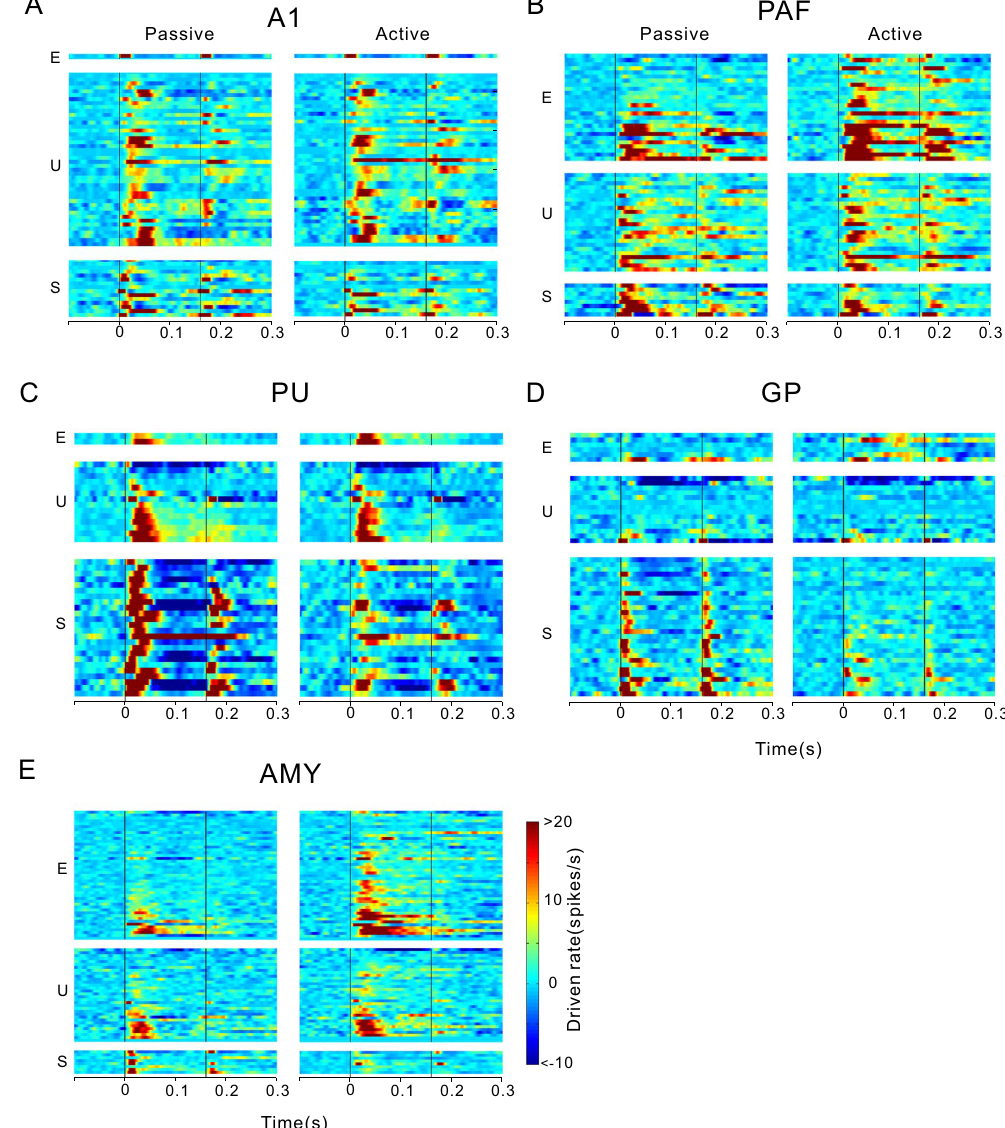
Figure 5. Effects of task-engagement on the tone-evoked responses in the neural population of different brain areas. Individual peri-stimulus time histograms (PSTHs) of enhanced (E), unchanged (U), and suppressed (S) units are aligned at stimulus onset and displayed in color-scaled plots. Black vertical lines show stimulus onset and